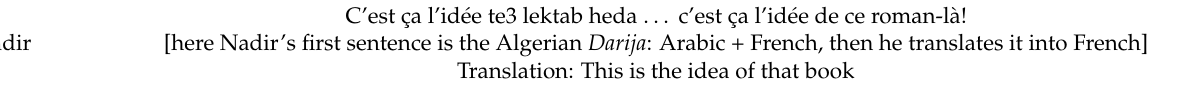
Table 1. Examples of Nadir’s multilingual